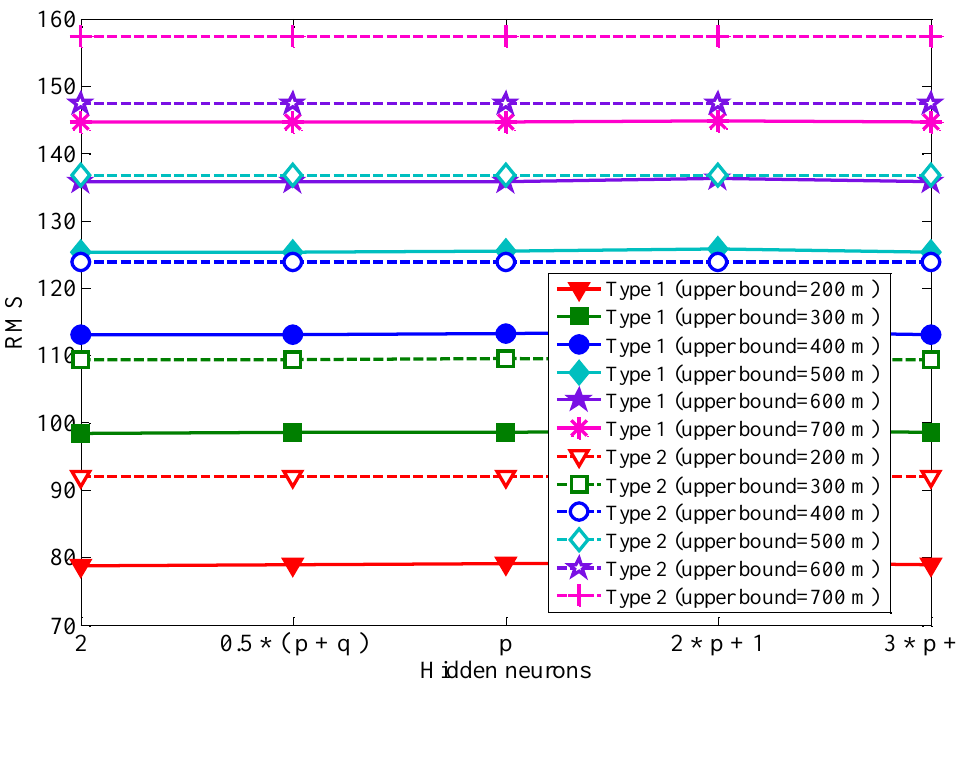
Figure 6. The RMS errors with various neurons numbers of hidden